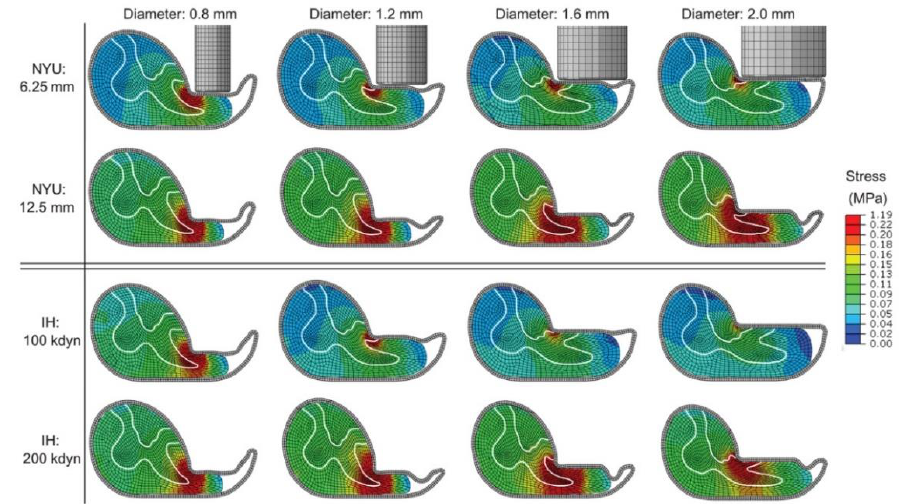
Figure 4. Stress distributions in the transverse view at the maximum compression for the NYU and IH impactors at impactor tip diameters of 0.8 mm, 1.2 mm, 1.6 mm, and 2.0 mm.